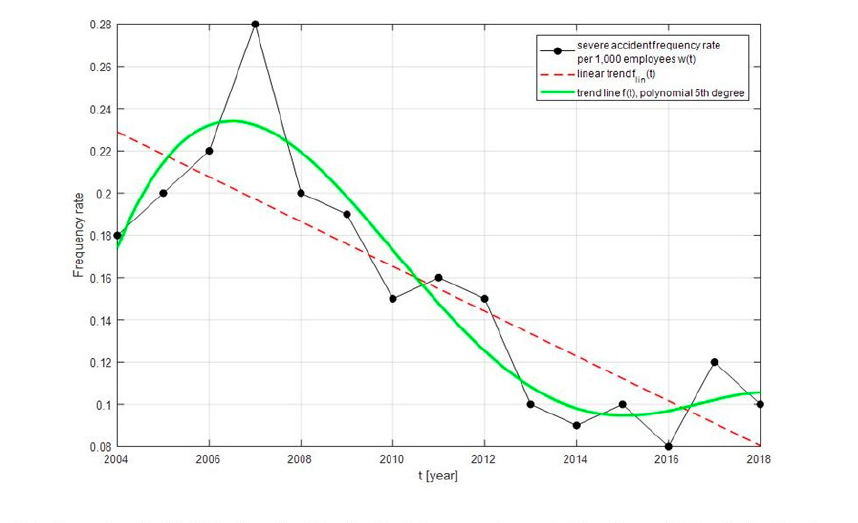
Figure 7. Trends of changes in the frequency of severe accidents in civil engineering over time.